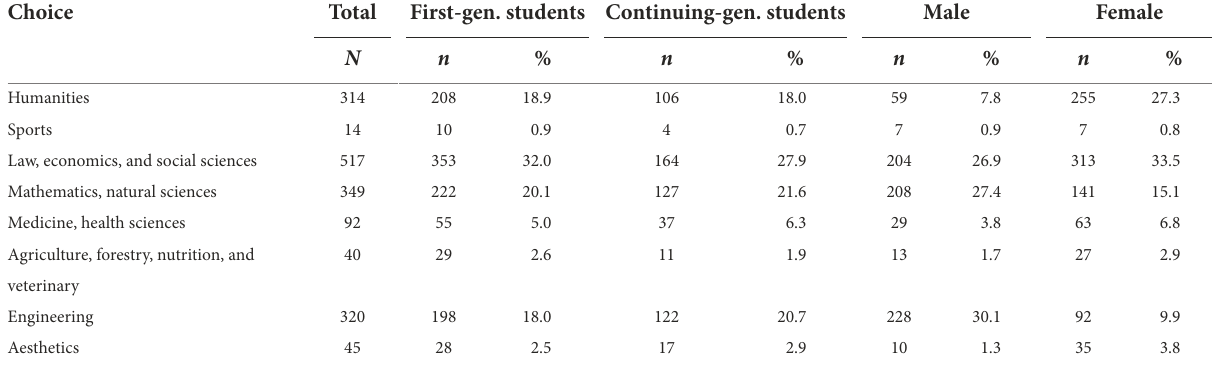
TABLE 3 Frequencies of first-generation, continuing-generation, female, and male students’ study program choices. Choice